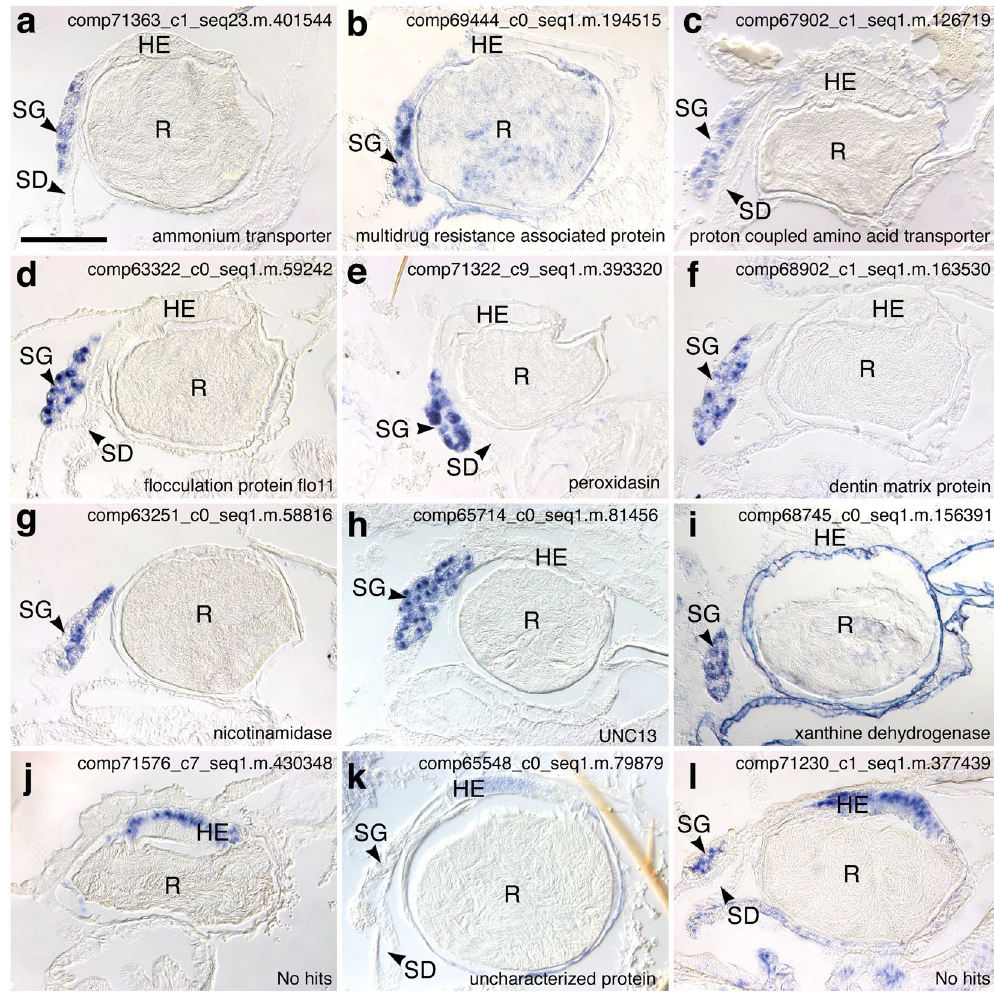
Figure 6. Expression patterns of 12 contigs that were only expressed in the spermatheca. Scale bar, 100 µ m; HE, hilar columnar epithelium of the spermathecal reservoir; R, reservoir; SD, spermathecal duct; SG, spermathecal